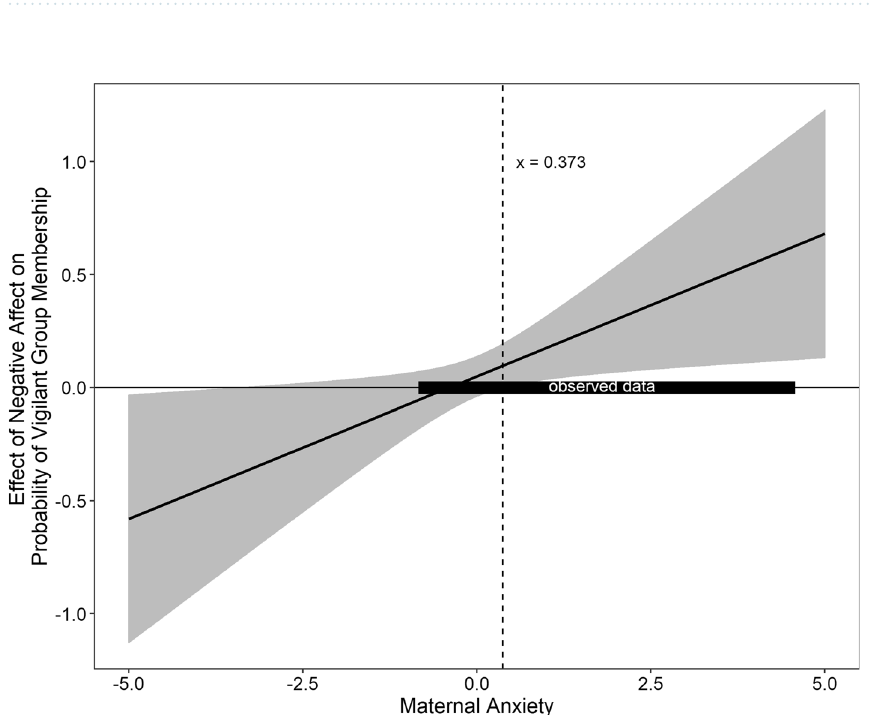
Figure 2. Regions of significance figure probing the moderating role of maternal anxiety on the relation between negative affect and probability of vigilant group membership. The dashed vertical line indicates the point at which the relation becomes significant. The dark horizontal bar represents our observed range of maternal anxiety scores. Results suggest that at higher levels of maternal anxiety and negative affect infants have a higher probability of being in the vigilant